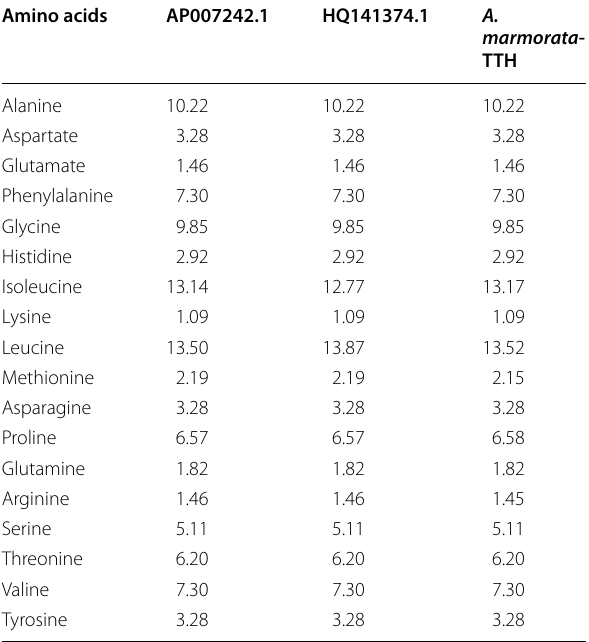
Table 4 Amino acids composition of COI of Anguilla marmorata